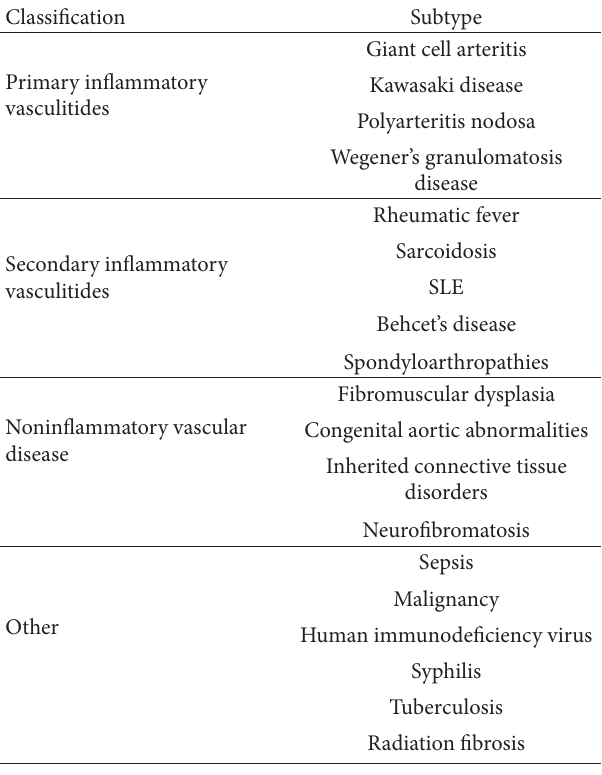
Table 2: Differential diagnosis of Takayasu